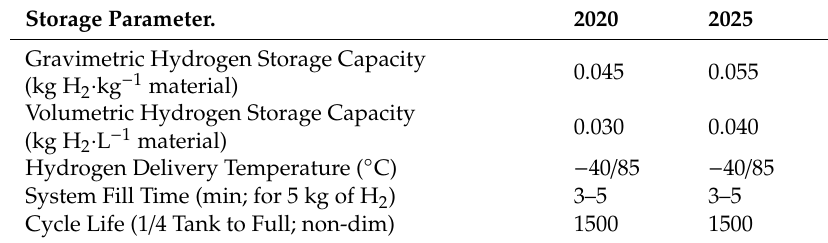
Table 1. Selected US Department of Energy’s (DOE’s) hydrogen storage systems-targets for 2020 and 2025. Adapted with web policies copyright, restrictions, and permissions notice of DOE [15]. Storage